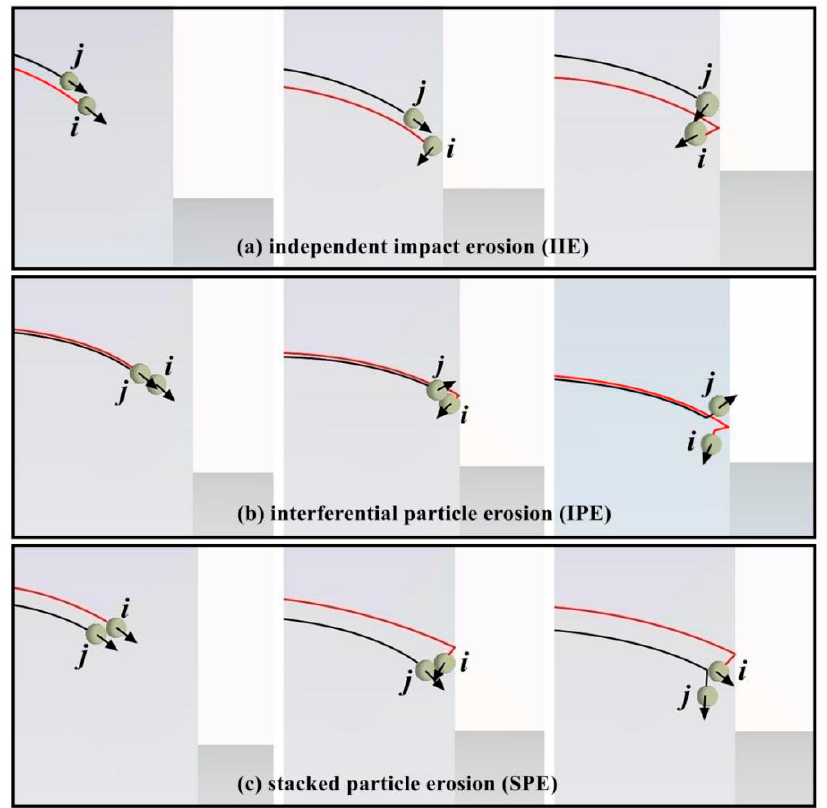
Figure 19. Schematic diagrams of particle-wall and particle-particle collisions between two particles.